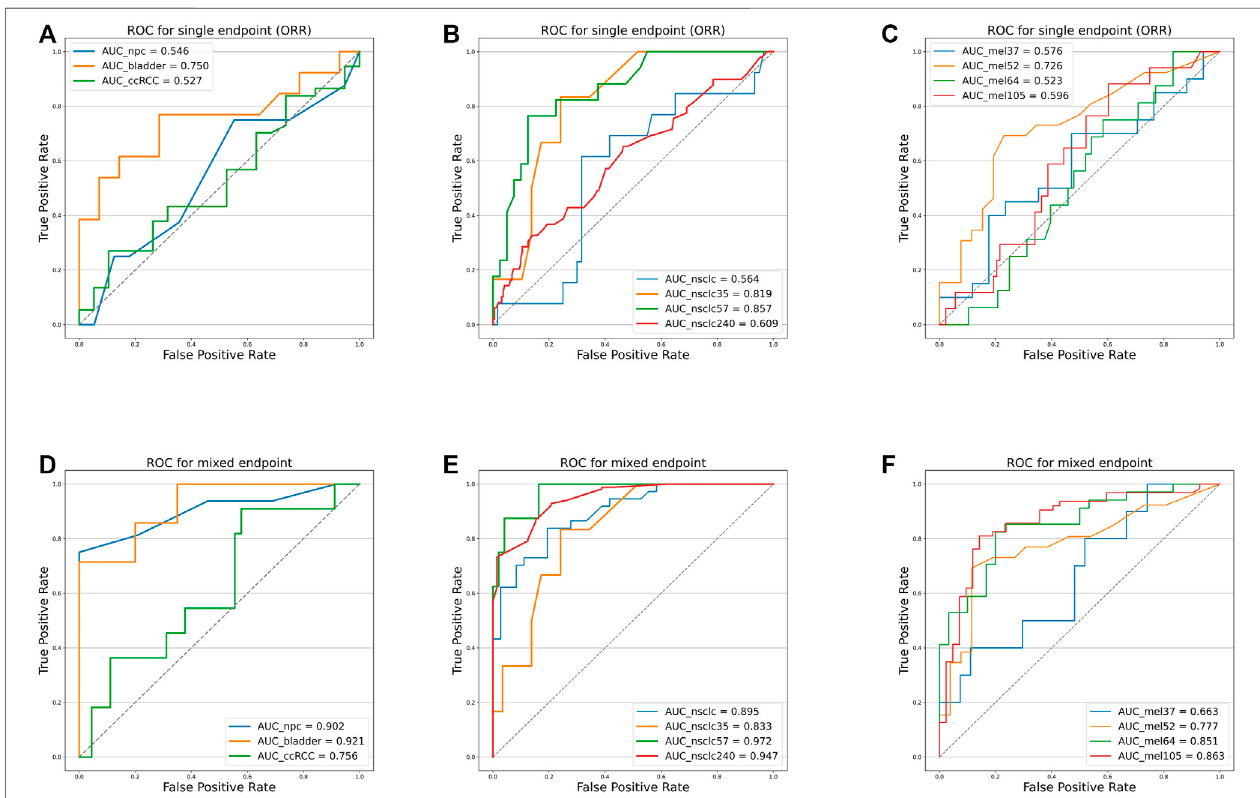
FIGURE 4 | Receiver operating characteristic curves of the predictive capacity of prognosis label for two experiment cohorts and validation cohorts, depicting the true-positive rate (sensitivity, y -axis) and false-positive rate (1-speci fi city, x -axis) for the metric across all possible TMB thresholds. The corresponding area under the curve(AUC)isillustratedinthe fi gurelegends. (A) ROCcurvesforNPC(panel)experimentcohort,bladdercohort,andRCC cohortbasedonORRlabelsalone. (B) ROC curves for NSCLC (WES) experiment cohort, NSCLC_35 cohort, NSCLC_57 cohort, and NSCLC_240 cohort based on ORR labels alone. (C) ROC curves for Mel_37cohort,Mel_52cohort,Mel_64cohort,andMel_105cohortbasedonORRlabelsalone. (D) ROCcurvesforNPC(panel)experimentcohort,bladdercohort,and RCCcohortbasedonthemixed-endpointlabels. (E) ROCcurvesforNSCLC(WES)experimentcohort,NSCLC_35cohort,NSCLC_57cohort,andNSCLC_240cohort based on the mixed-endpoint labels. (F) ROC curves for Mel_37 cohort, Mel_52 cohort, Mel_64 cohort, and Mel_105 cohort based on the mixed-endpoint labels.